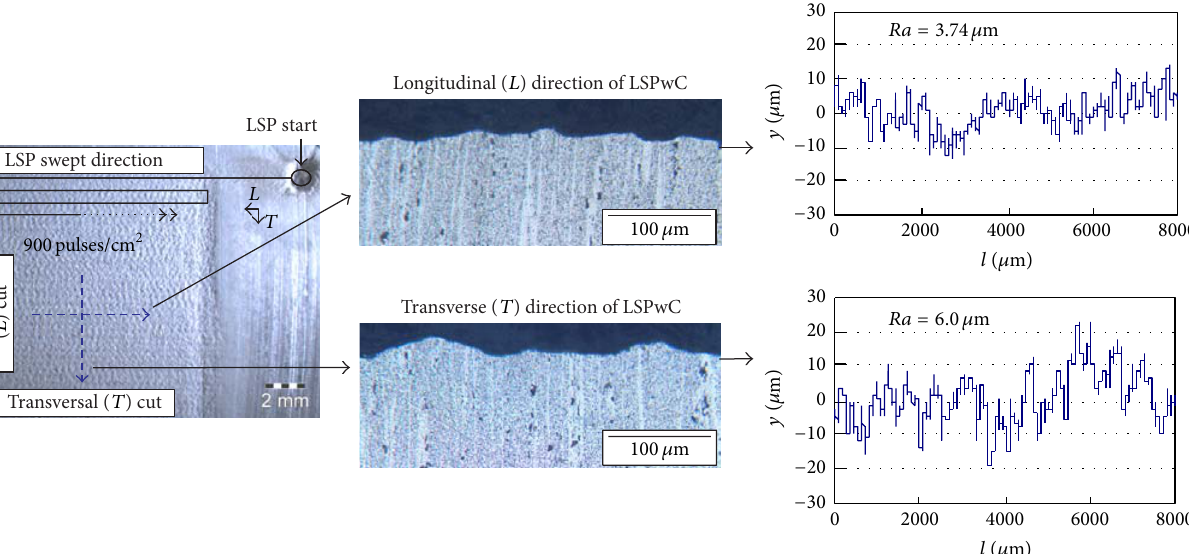
Figure 3: Presentation of LSPwC surface scan and microsection of LSPwC treated sample with resulting surface profile.